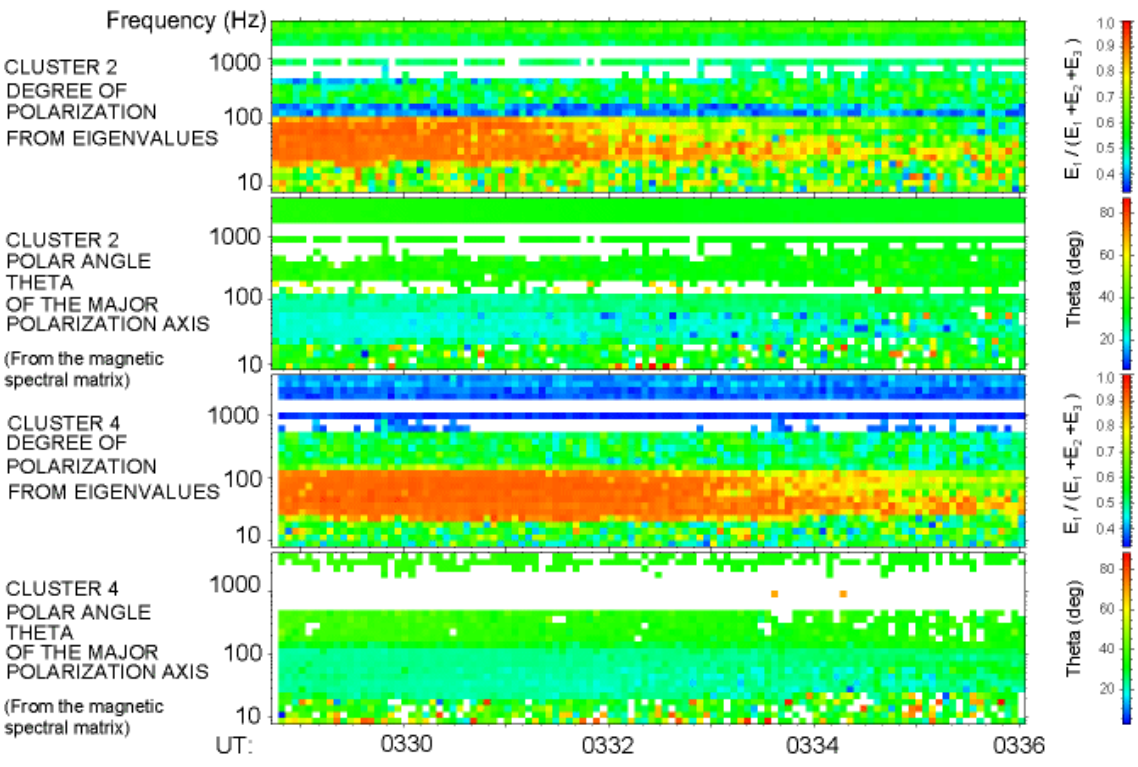
Fig. 7b. Results of the characterisation of the waves for two spacecraft (it is the same for the two others) for the event shown on Fig. 7a. Panels 1 and 3 from top to bottom give the degree of polarisation, whereas panels 2 and 4 give the angle between the principal axis of the polarisation of the magnetic components of the waves and the main magnetic field which is about 10 ◦